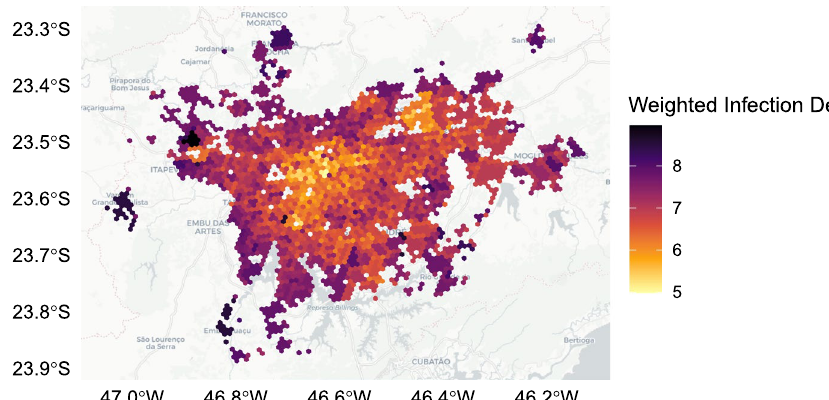
Fig. 8 Geographic distribution of weighted median infection delay values over the first ten days of an